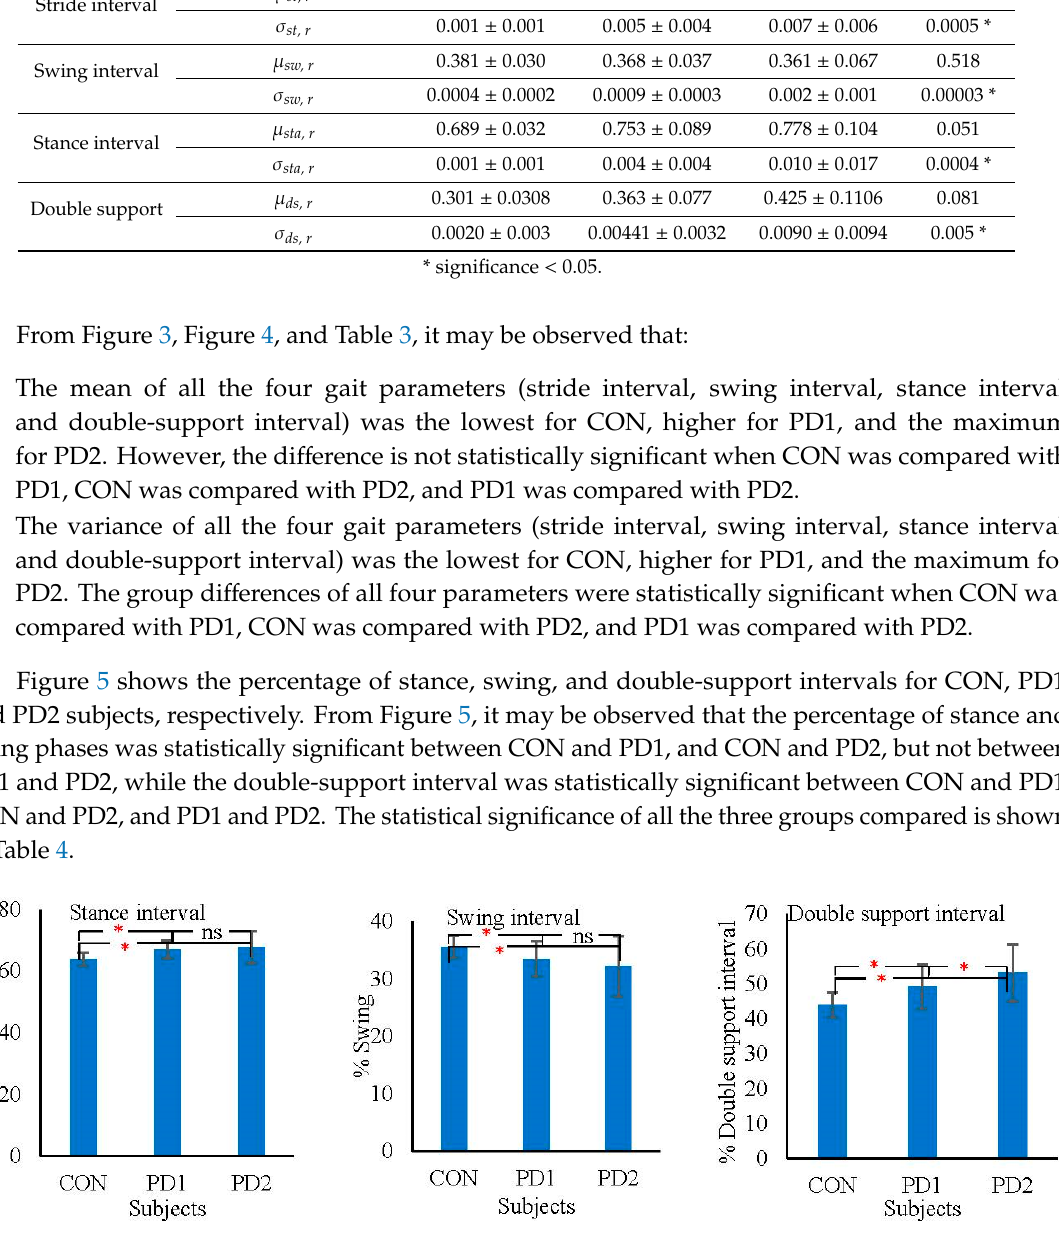
Figure 5. Bar chart showing the percentage of stance, swing, and double-support intervals for different groups (* p (significance) < 0.05, ns (nonsignificant). Table 4. Percentage of stance, swing, and double-support intervals when CON, PD1, and PD2 groups are compared.